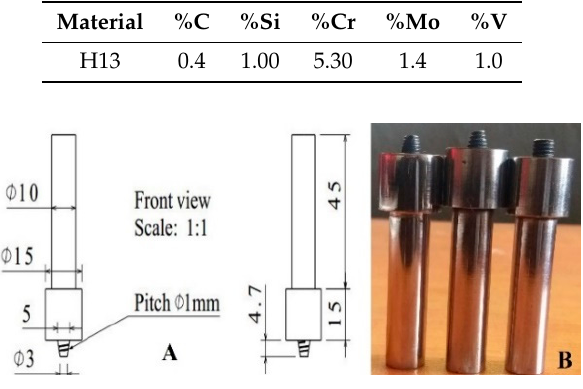
Figure 4. ( A ) Geometric dimensions of the tool, ( B ) From left to right tri-flute threaded, taper threaded and cylindrical threaded tools.